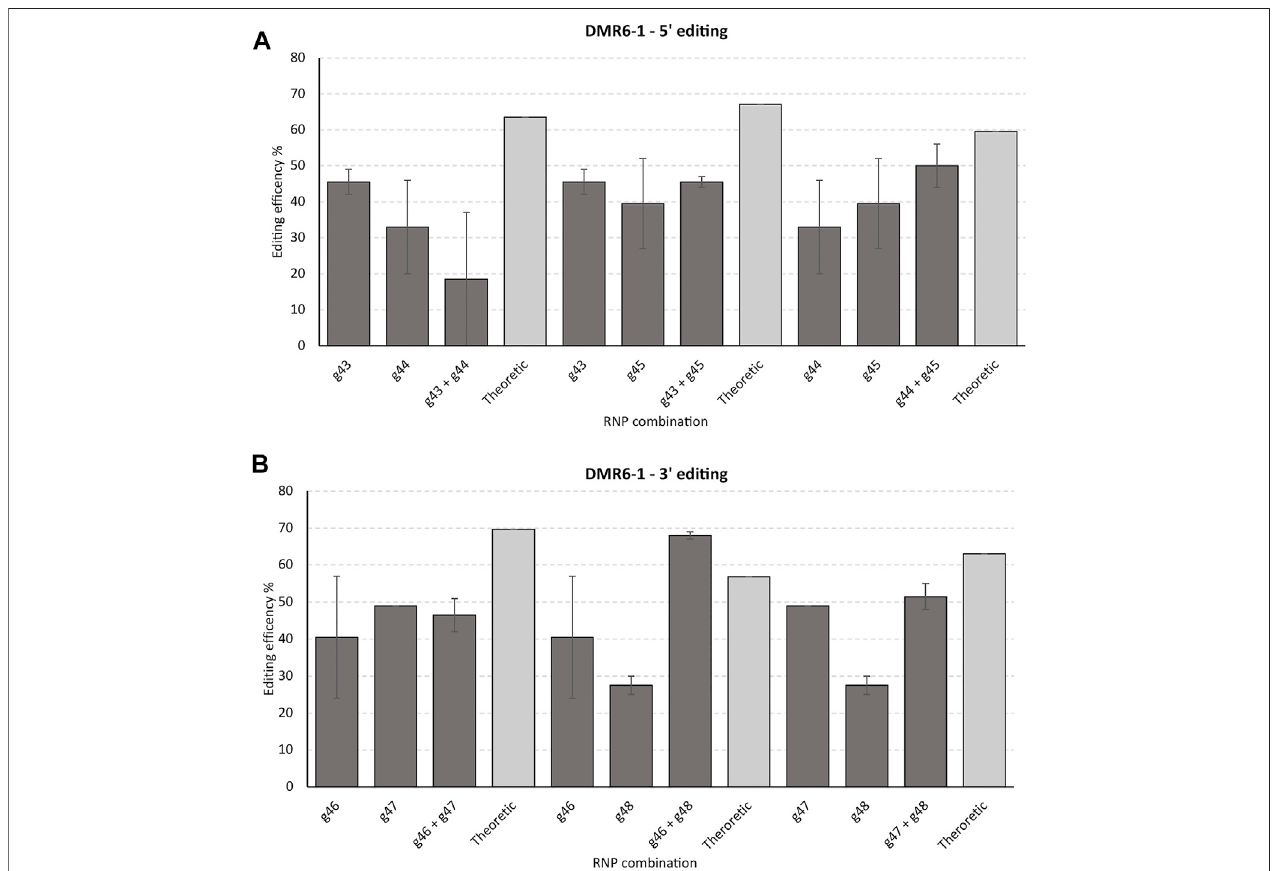
FIGURE 4 | Targeting the 5 ’ versus the 3 ’ end of DMR6-1 and effect of multiplexing . 6 gRNAs were designed to target the 5 ’ (g43, g44, and g45) (A) and 3 ’ end (g46, g47, and g48) (B) of DMR6-1, respectively. The gRNAs were tested individually and in combination. Theoretical designates the sum of the individual two gRNAs editing ’ s (2 biological replicates were performed with std errors indicated). gRNAs and IDAA primers used: g43, g44, and DMR6 Forward primer 1 + DMR6 Reverse primer 1; g45 and DMR6 Forward primer 2 + DMR6 Reverse primer 2; g46, g47 & g48 and DMR6 Forward primer 3 & DMR6 Reverse primer 3 (see Material and Methods ).